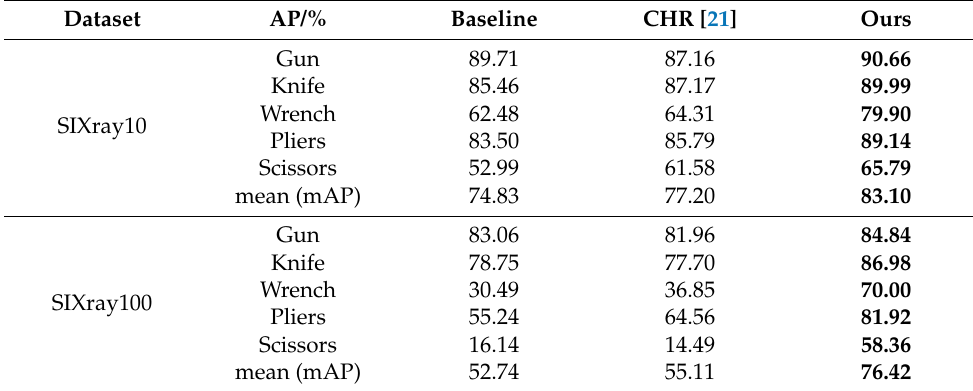
Table 7. Result of multi-label classification performance.